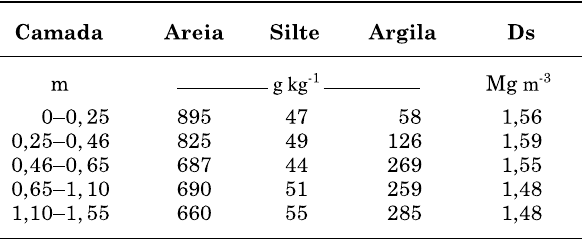
Figura 2. Umidade do solo em função ln( h ) com h em MPa, kPa e hPa.